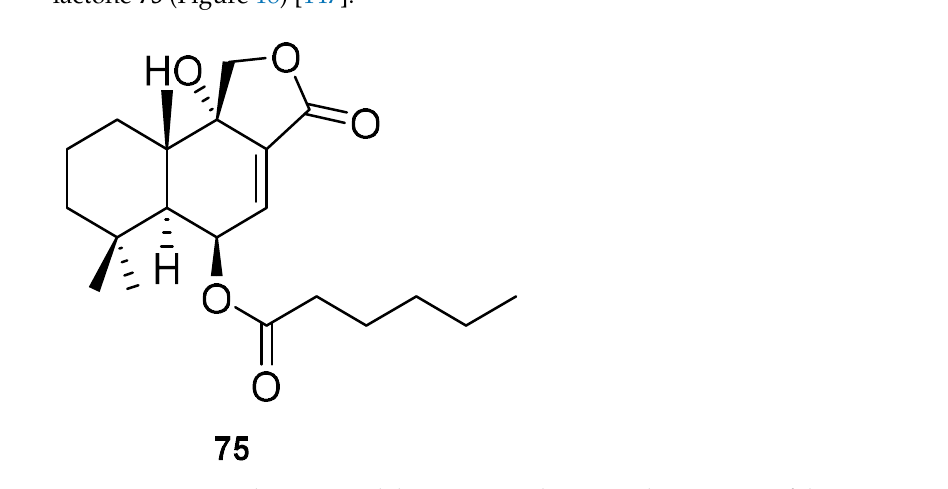
Figure 18. Drimane lactone 75 inhibits NF- κ B and Stat-3 to the promoter of the survivin gene [147]. In further experiments, it was shown that 75 inhibits DNA binding of the transcrip- tion factors NF-kB and Stat-3 to the survivin promoter. DNA binding of NF- κ B